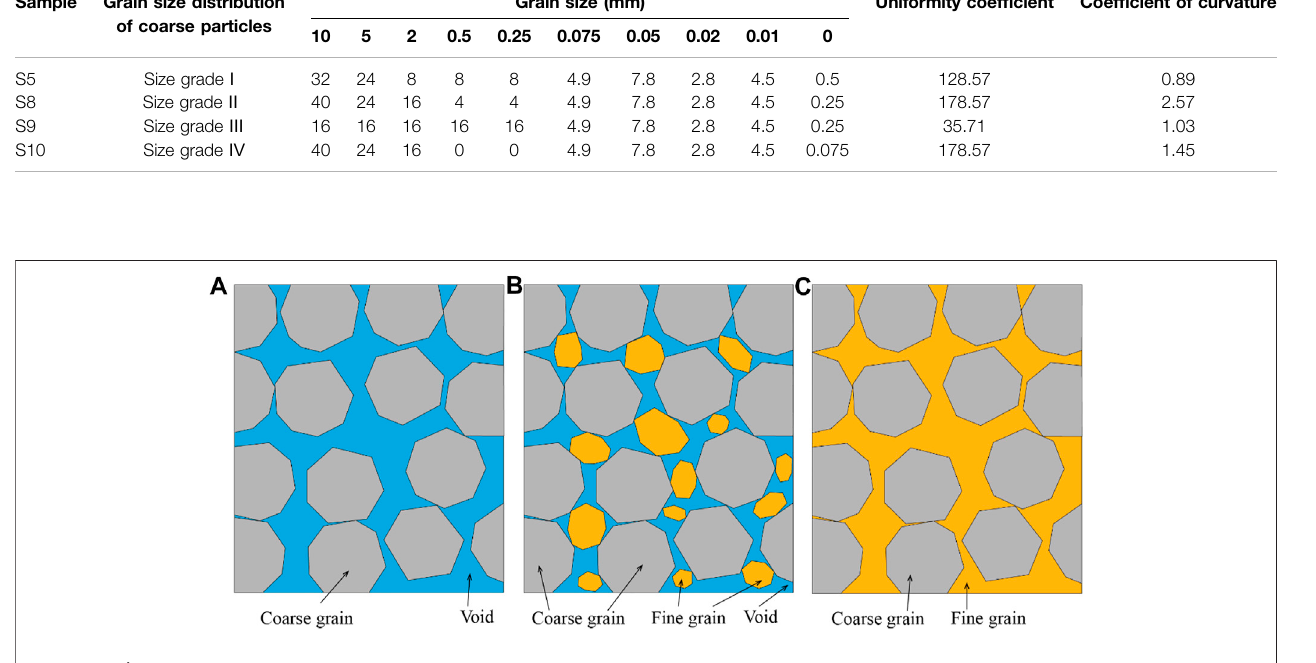
FIGURE 11 | Distribution models of CGS. (A) CGS without fi nes; (B) CGS without partial fi nes; and (C) CGS with saturated fi nes.